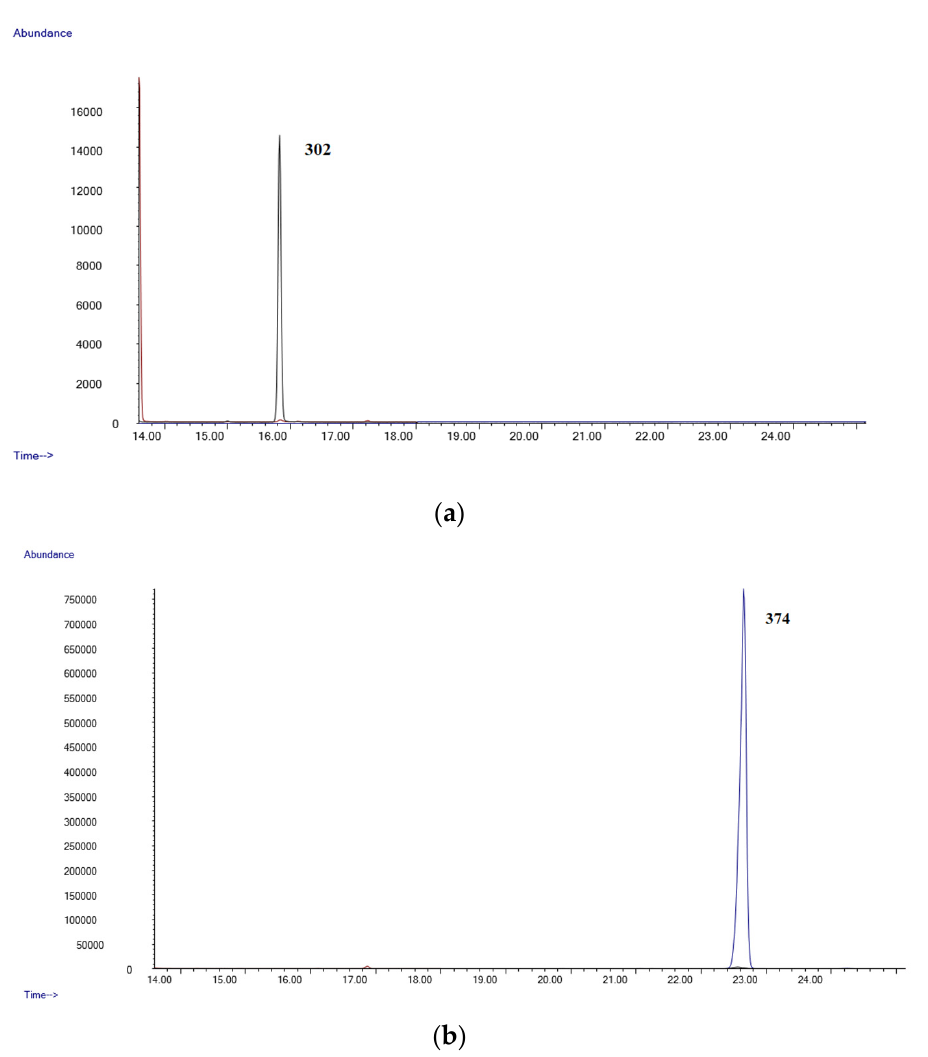
Figure 1. ( a ) Chromatogram of a blank blood sample ( Δ 9-THC); ( b ) chromatogram of a blank blood sample ( Δ 9-THC-COOH).